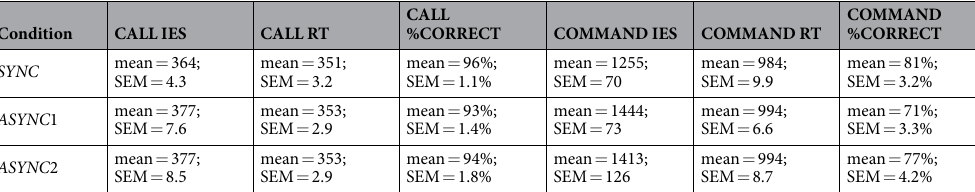
Table 2. Performance Results Control Experiment. Mean and standard error of the mean for the different conditions and performance variables (Inverse Efficiency Score (IES); Response Time (RT), and % of Correct responses).